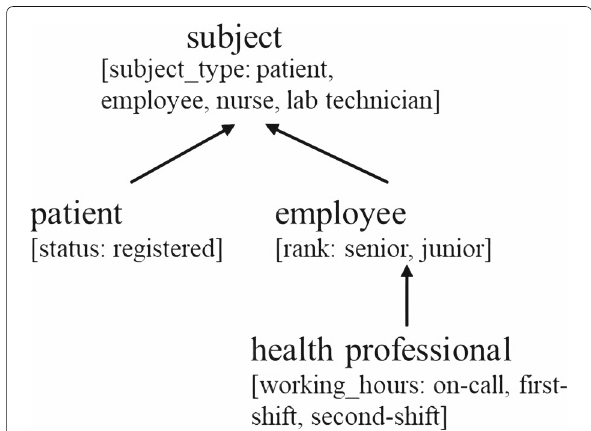
Fig. 8 Example of subject group hierarchy represented as a graph.